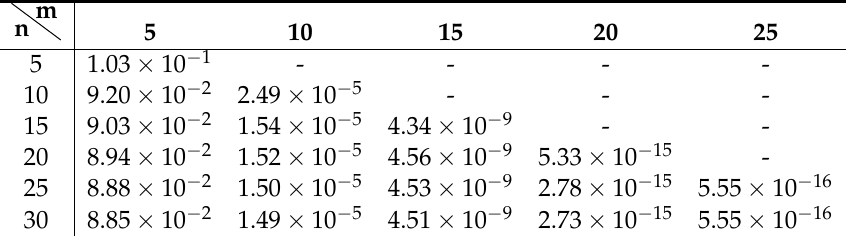
Table 6. Maximum test set solution error using Legendre polynomials for Problem #